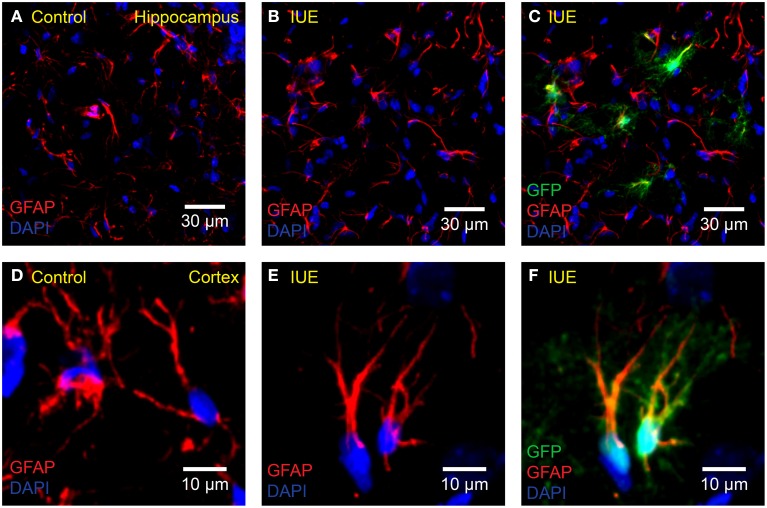
No apparent astrogliosis following IUE. Confocal imaging of astrocyte GFAP in the (A–C) hippocampus or (D–F) cortex of (A,D) unelectroporated controls or (B,C,E,F) following IUE of CAG-GFP-IRES-Neo (green). For better comparison with (A), (B) displays only the red (anti-GFAP) and blue (DAPI) channels of (C). Likewise, for comparison with (D), (E) displays the anti-GFAP and DAPI channels of (F). Transfected astrocytes are partially yellow/orange. There were no striking qualitative differences in GFAP expression and morphology between age-matched (P18) control and IUE groups, even in transfected astrocytes.